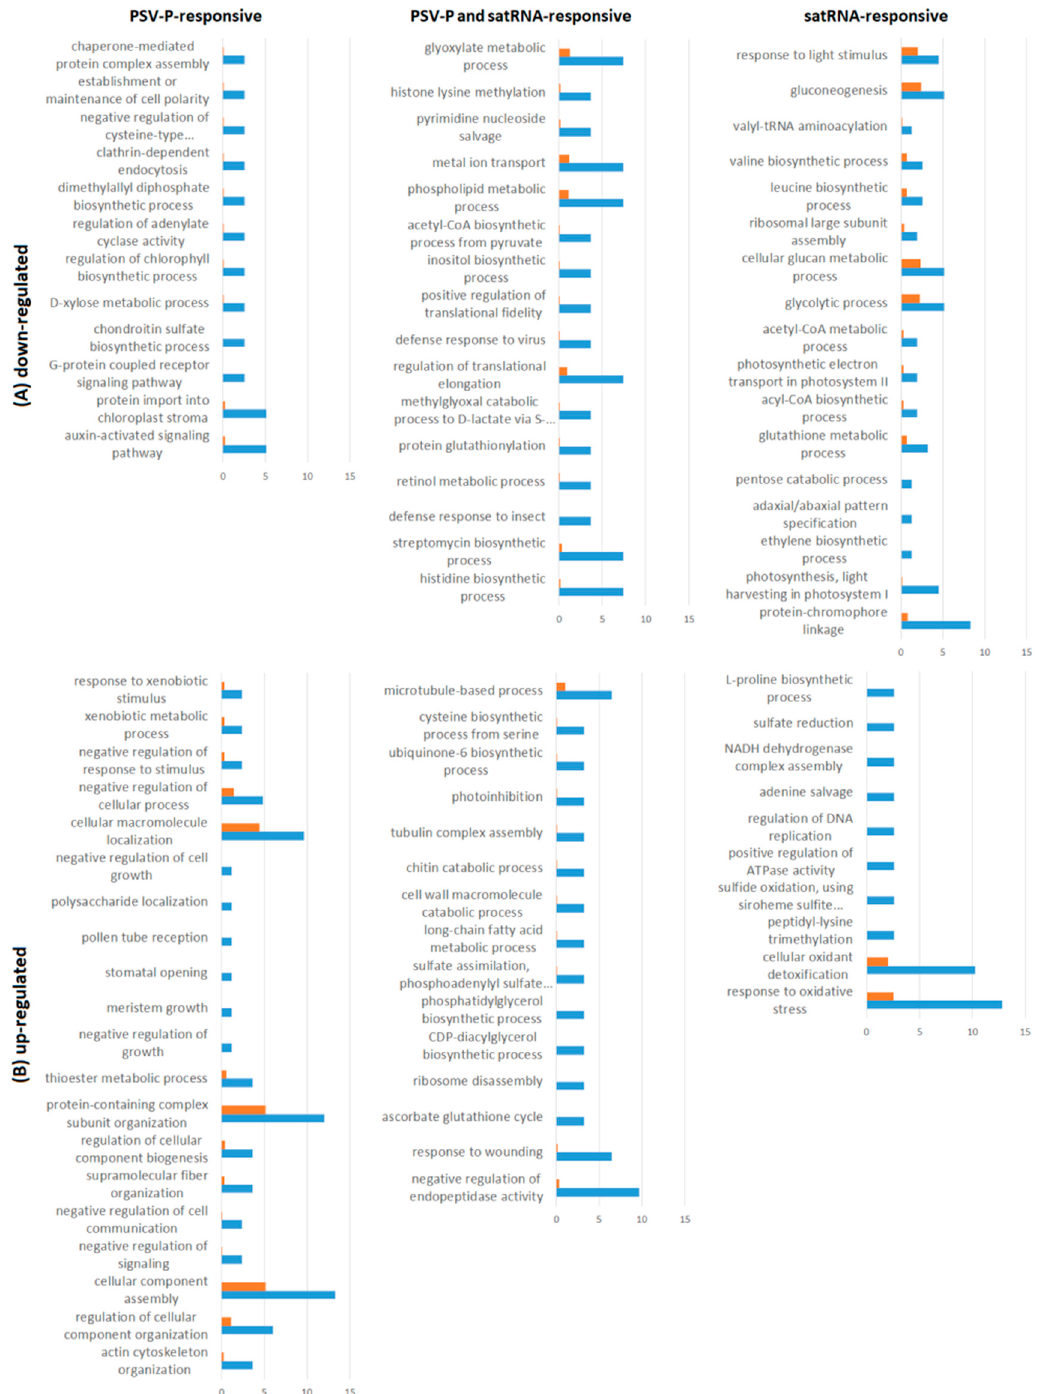
Figure 3. Gene ontology (GO) enrichment for the biological process for proteome analysis. Graphs display GO terms for PSV-P- or PSV-P and satRNA-infected N. benthamiana plant proteins. The distribution of GO terms was analyzed separately for down-regulated ( A ) and up-regulated proteins ( B ) using Blast2GO Basic.